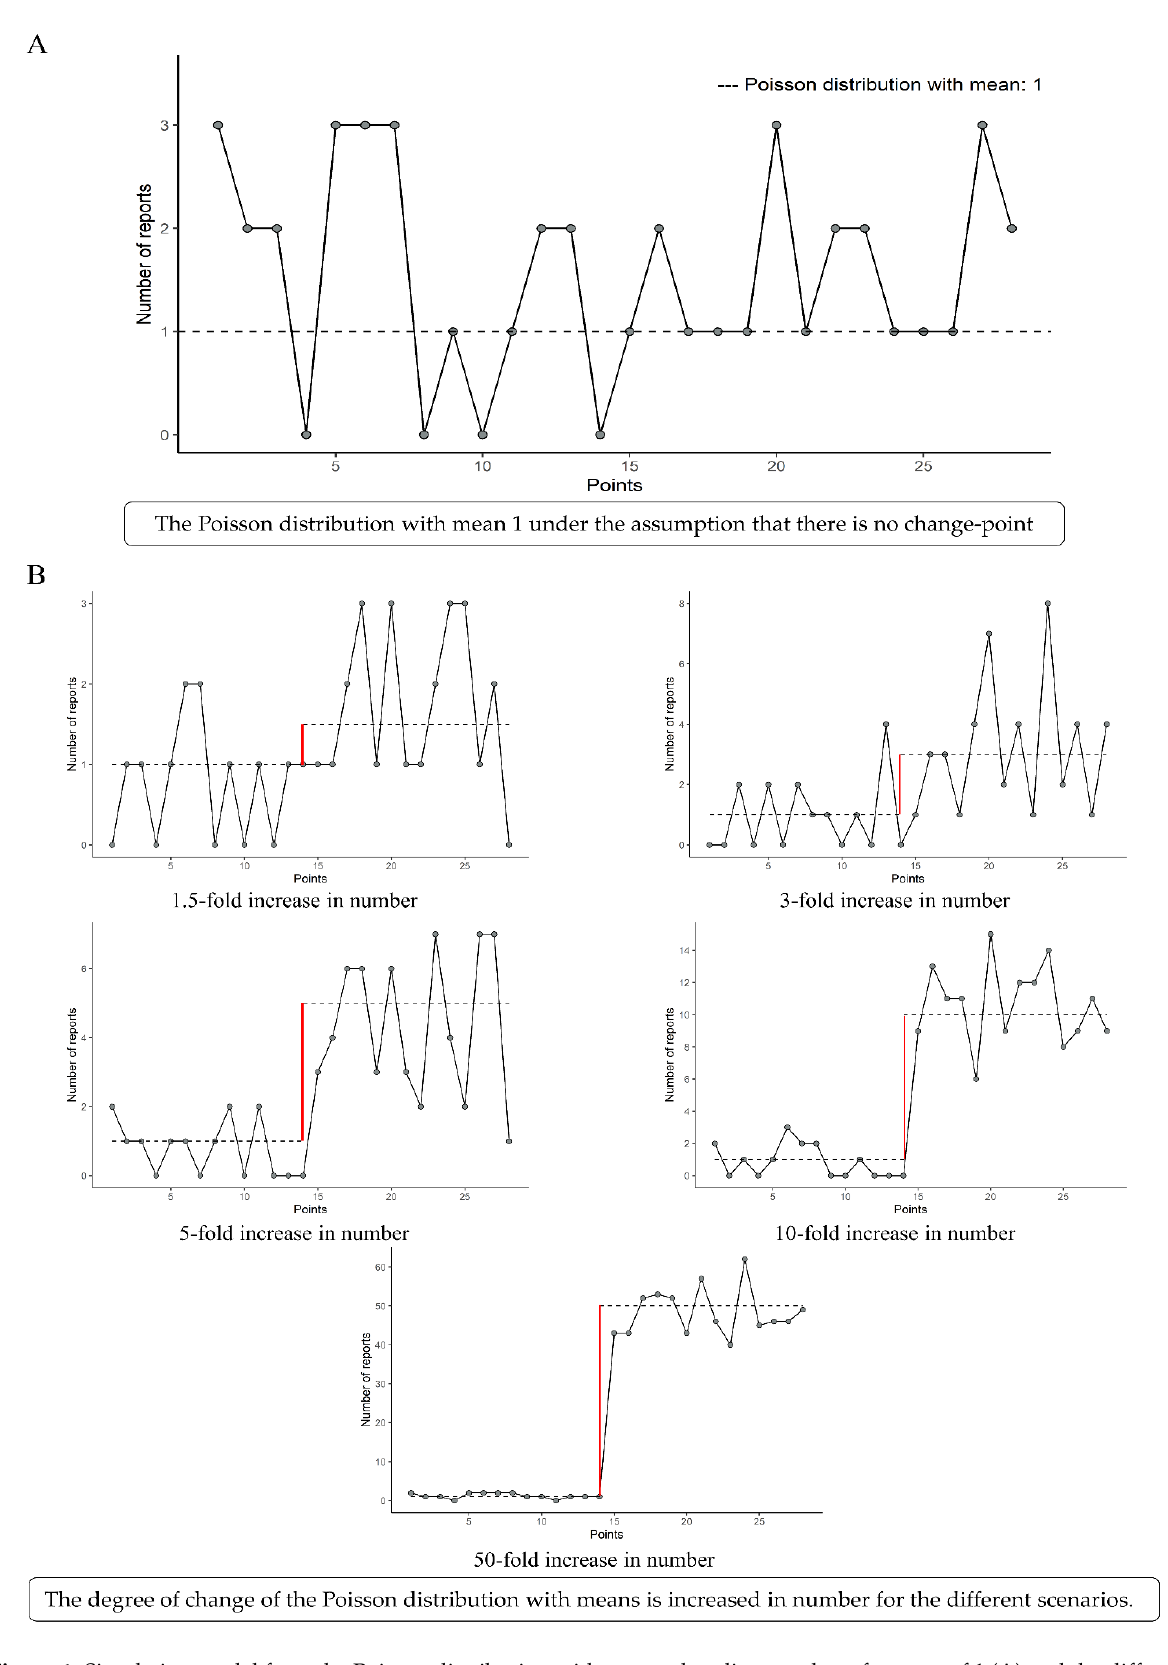
Figure 1. Simulation model from the Poisson distribution with a mean baseline number of reports of 1 ( A ) and the different scenarios with 1.5-, 3-, 5-, 10-, and 50-fold increases in number ( B ).